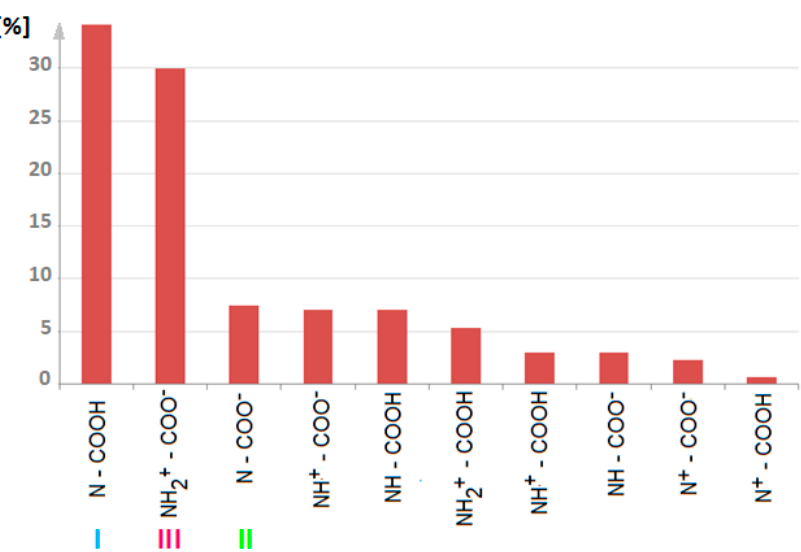
Figure 2. Percentage occurence of proline-based tectons in the CSD (three types of proline-based tectons, I, II, III, are color-coded, see chapter below).